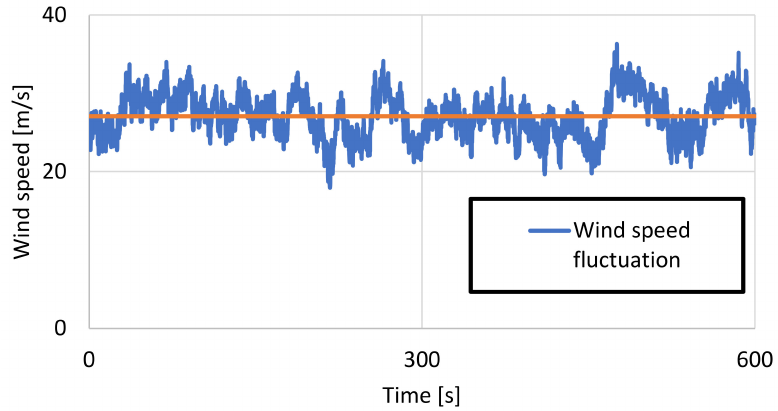
Figure 12. The wind fluctuation calculated for the location of the Bishop Rock lighthouse over a period of 10 min (600